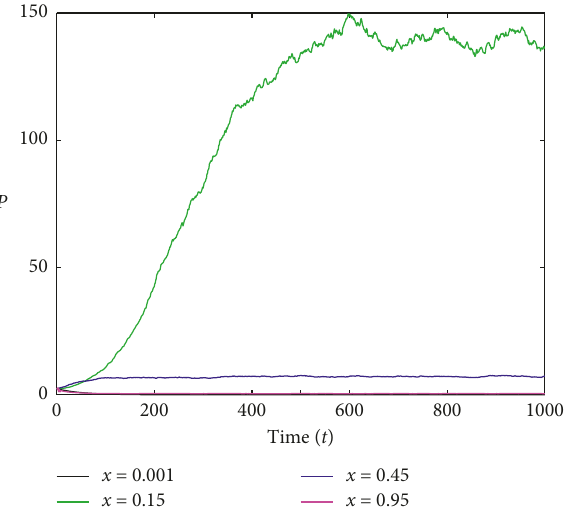
Figure 6: The solution of phytoplankton in model (3) with different cell size x , where the noise intensity is fixed to δ � 0 . 1, and the black curve is for x � 0 . 001, the green curve is for x � 0 . 15, the blue curve is for x � 0 . 45, and the pink curve is for x � 0 . 95.